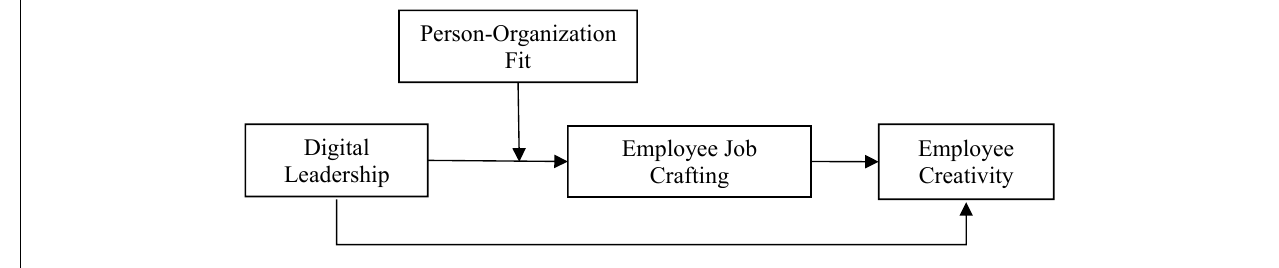
FIGURE 1 | Theoretical